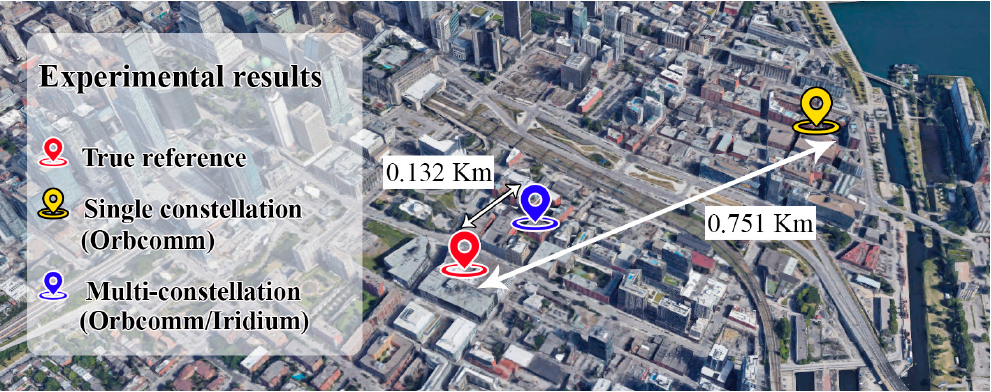
Figure 12. Positioning results for a stationary receiver using single-constellation (Orbcomm) and Multi-constellation (Orbcomm and Iridium-Next) receiver modes.